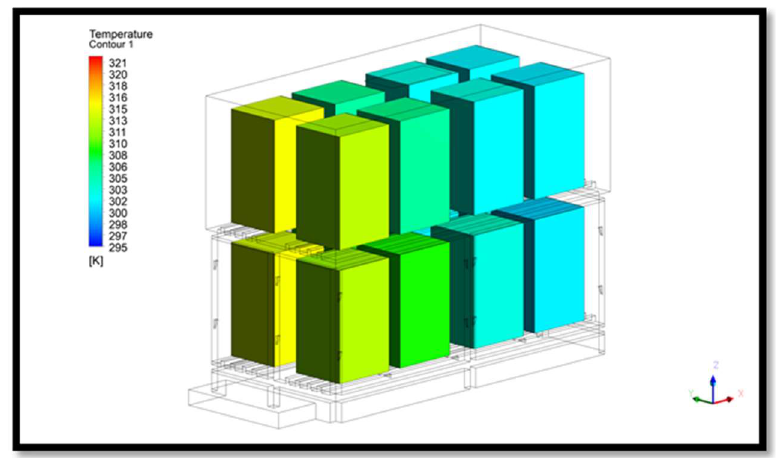
wake can be seen trailing the feature.